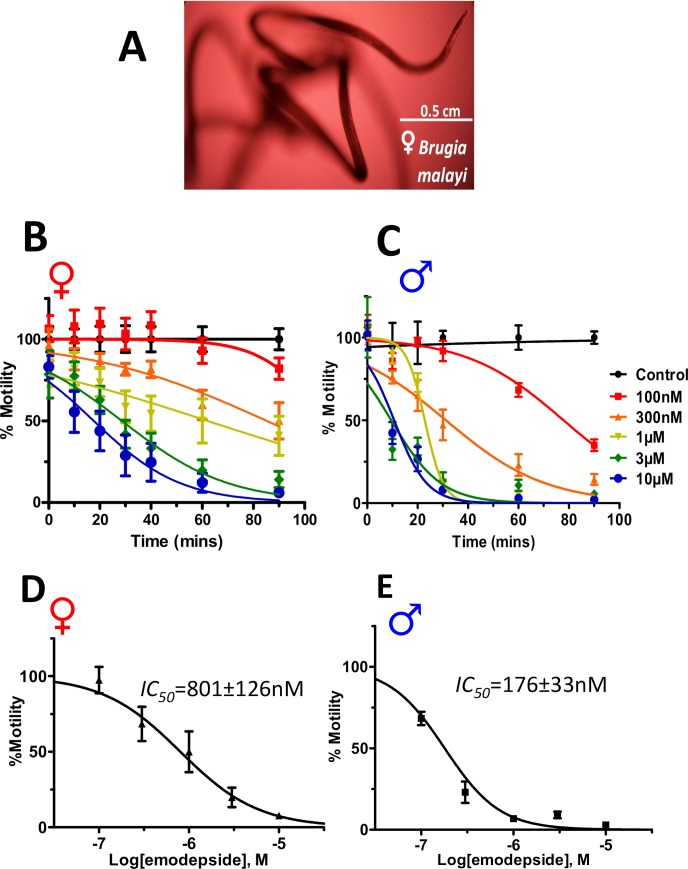
Emodepside causes inhibition of motility of whole adult Brugia malayi that is concentration-, time-, and sex-dependent.A: Representative micrograph of an untreated adult female B. malayi. The worm is characteristically coiled and was showing continuous vigorous vibrating movements. B: (female symbol) Concentration- and time-dependent emodepside inhibition of motility on adult B. malayi females and C: (male symbol) males. Motility plotted at 60 minutes for both females and males (D: female symbol:
IC50 (female), 801 ± 126nM (SEM)) and males (E: male symbol:
IC50 (male), 176 ± 33 nM (SEM)). Each treatment group was normalized to the motility at time 0. N = 12, over two biological replicate experiments. The female IC50 was significantly higher than the male (p<0.001; 2-way ANOVA). The male is more sensitive to emodepside than the female.